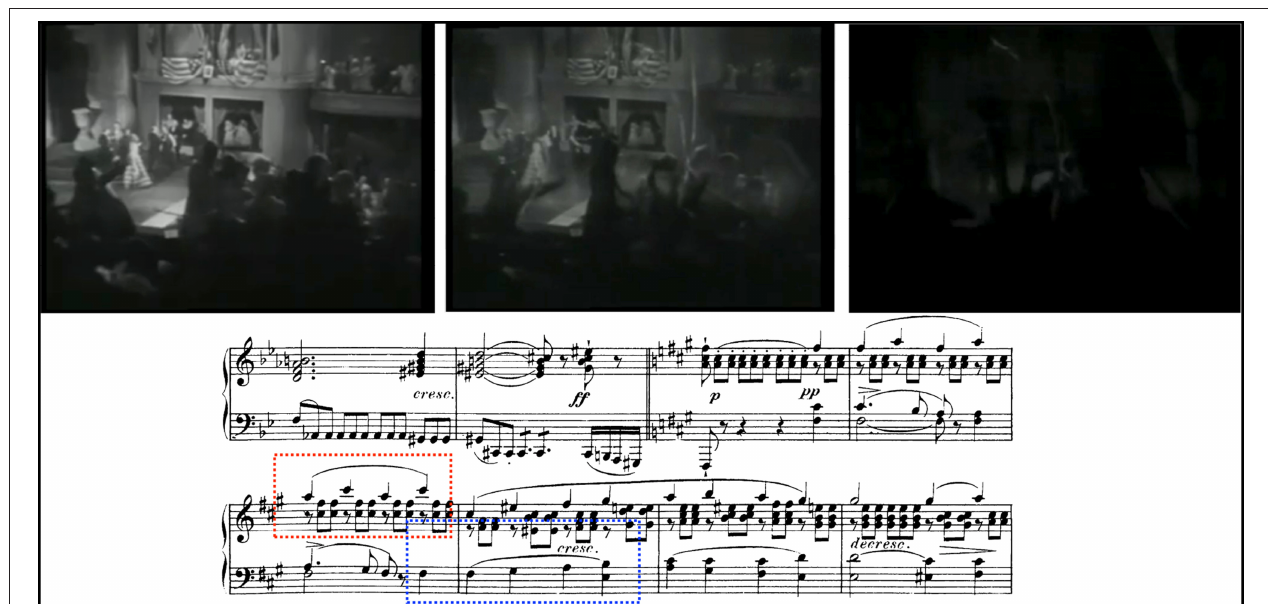
FIGURE 10 | Although the data are of different natures, images in films and audio samples in music signals share common semantic relations. For instance the phenomenon of fade-out/fade-in in a film, where images are superimposed during the transition [see the example of D. W. Griffith’s Abraham Lincoln film (Top) ] finds a correspondence in music when one subphrase finishes while another begins [see the extract of Schubert D.960 sonata (Bottom) ]. Transfer of knowledge of transitions in movies could help finding transitions in audio signals. Source of the images: screenshots of the movie. No permission is required for their use: the film entered the public domain in 1958 when the initial copyright expired. See Paolo Cherchi Usai (2008), The Griffith Project: Essays on D.W. Griffith , British Film Institute. p. 208. Retrieved January 16,